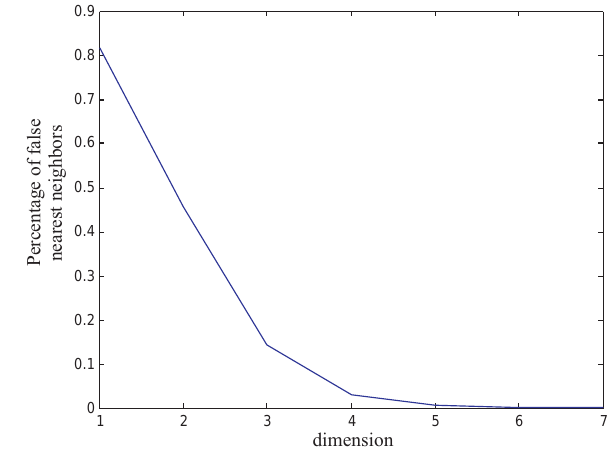
Figure 1: Fig. 1. Plot of the percentage of the false nearest neighbors versus the space dimension. For dimensions greater than or equal to 6 the percentage falls well below